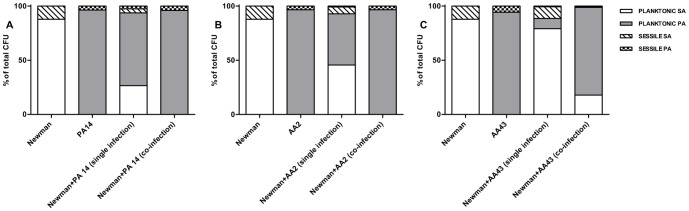
Percentage of planktonic and sessile cells in single and dual cultures.Bacteria were grown overnight in 96-well flat-bottom microtiter plates in NB medium at 37°C either individually cultured or co-cultured at a 1∶1 ratio. CFU counts were determined in both planktonic and sessile fractions and the percentage of S. aureus and P. aeruginosa in the two fractions of single and dual cultures was calculated. Panel A: percentages of planktonic and sessile cells of Newman in single culture (first histogram), PA14 in single culture (second histogram), Newman and PA14 in ideal co-culture if the 2 species would not interfere each other (third histogram, percentages have been calculated considering the values of the first and second histograms), and Newman and PA14 in co-culture (fourth histogram). Panel B: percentages of planktonic and sessile cells of Newman in single culture (first histogram), AA2 in single culture (second histogram), Newman and AA2 in ideal co-culture if the 2 species would not interfere each other (third histogram, percentages have been calculated considering the values of the first and second histograms), and Newman and AA2 in co-culture (fourth histogram). Panel C: percentages of planktonic and sessile cells of Newman in single culture (first histogram), AA43 in single culture (second histogram), Newman and AA43 in ideal co-culture if the 2 species would not interfere each other (third histogram, percentages have been calculated considering the values of the first and second histograms), and Newman and AA43 in co-culture (fourth histogram). SA: S. aureus; PA: P. aeruginosa.